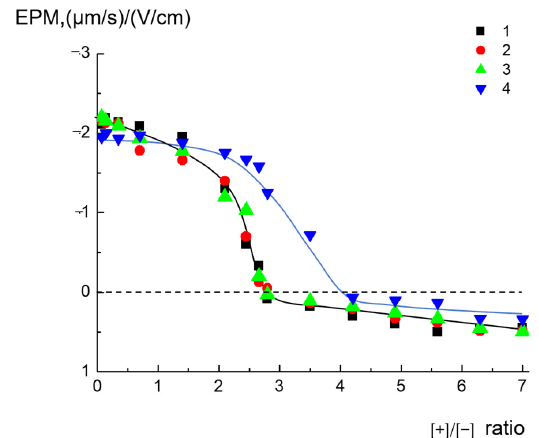
Figure 2. EPMs of the dendrimer–liposome complexes versus ratios of ionic groups [+]/[ − ] for D 350+ (1), D 229+ (2), D 215+ (3), and D 16+ (4), where [+] is the molar concentration of the pyridinium groups of dendrimers, and [ − ] is the molar concentration of negatively charged cardiolipin head- groups. CL/Chol/DOPC liposomes, [CL] = 1.5 × 10 − 4 mol/L, total lipid concentration of 1 mg/mL. 10 − 3 M phosphate buffer, pH